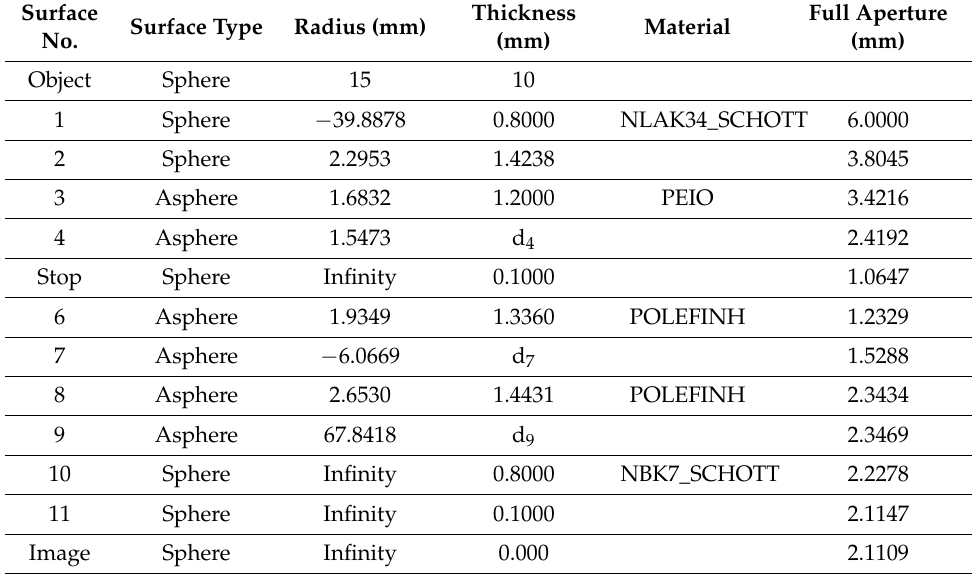
Table 1. Lens design data for 2 × zoom